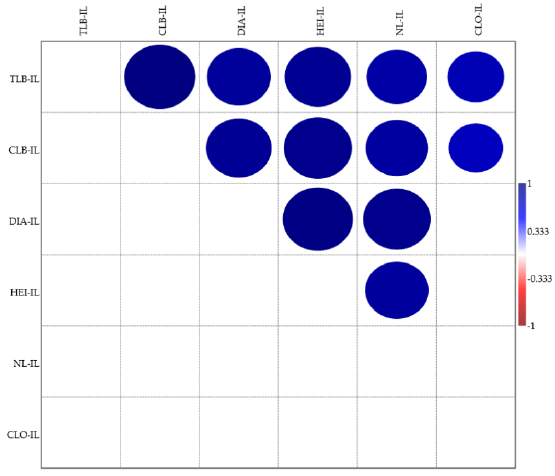
Figure 1. Pearson correlation between variables in iceberg lettuce (IL) submitted to different con- centrations of boiled chicken manure (BCM), Bokashi, and mineral fertilization in a greenhouse. Blue color represents the “+1” correlation coefficient and red color represents the “−1” correlation coefficient. Only significant ( p < 0.05) correlations are shown. Total leaf biomass (TLB), commercial leaf biomass (CLB), plant diameter (DIA), plant height (HEI), number of leaves (NL), and chlorophyll index (CLO).